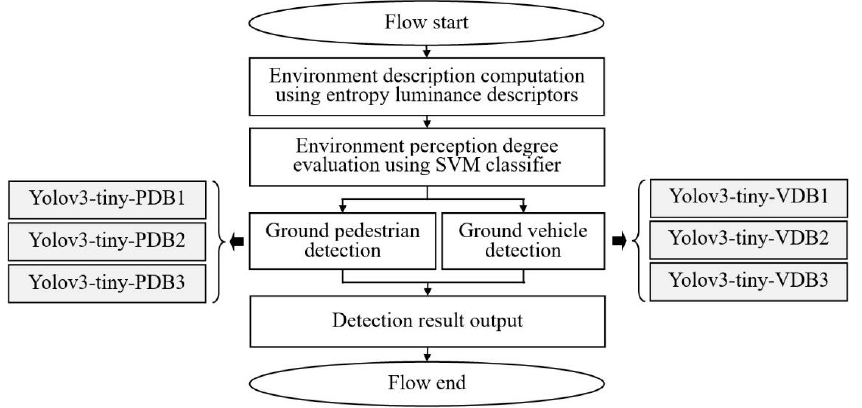
Figure 2. Proposed computational flow chart of ground pedestrian and vehicle detections.